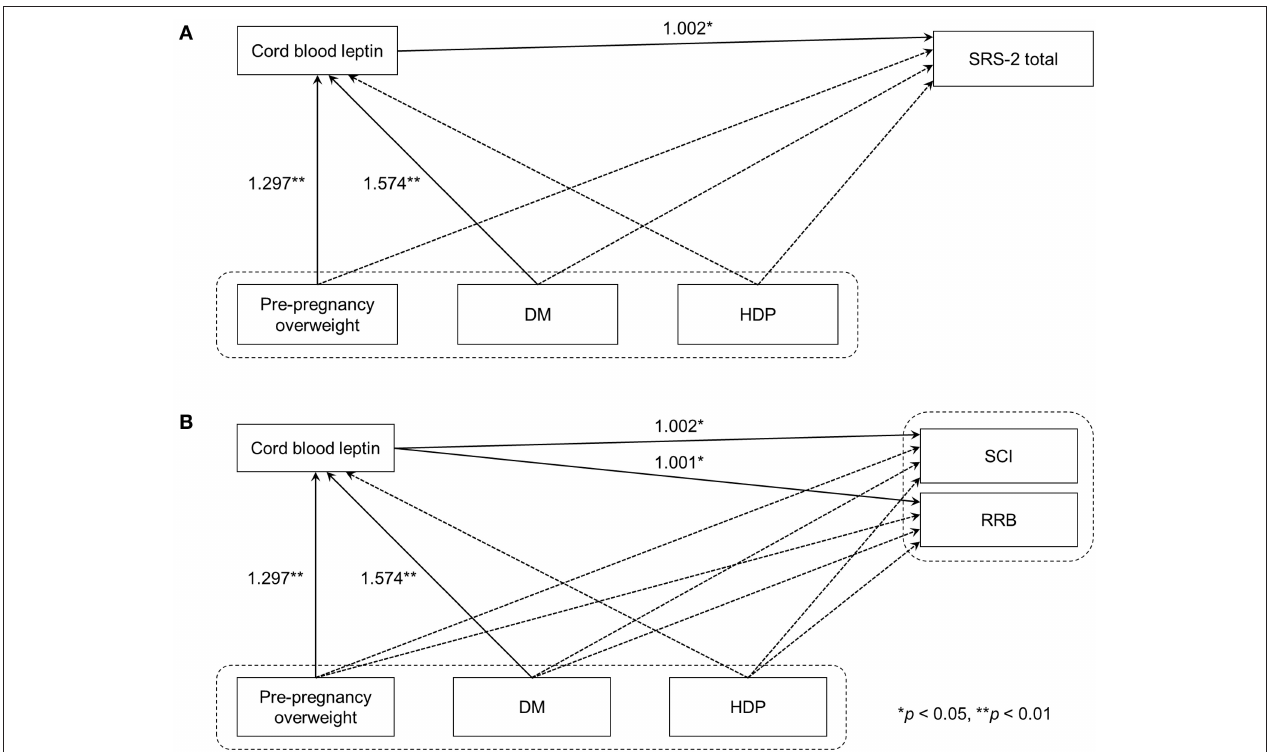
FIGURE 1 | Path analyses of maternal metabolic conditions, cord blood leptin concentrations, and autistic symptoms in children. (A) Model 1 used SRS-2 total T-scores as the indicator of autistic symptoms in children. (B) In Model 2, DSM-5 compatible T-scores were used instead. Solid line arrows and dashed line arrows indicate significant and non-significant associations between observed variables, respectively. Numbers represent exponentiated coefficients obtained from the analysis (* p < 0.05, ** p < 0.01). DM, diabetes mellitus before or during pregnancy; HDP, hypertensive disorders of pregnancy; SRS-2, the Social Responsive Scale, Second Edition; DSM-5, the fifth edition of the Diagnostic and Statistical Manual of Mental Disorders; SCI, Social Communication and Interaction; RRB, Restricted Interests and Repetitive